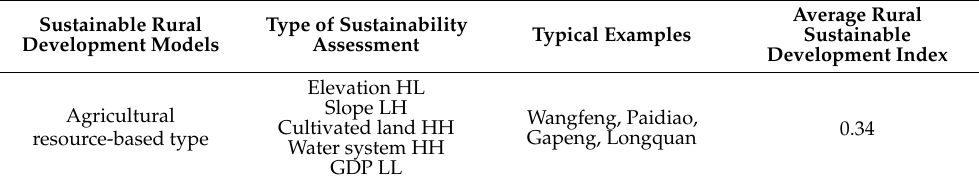
Table 5. Classification of rural development types based on local